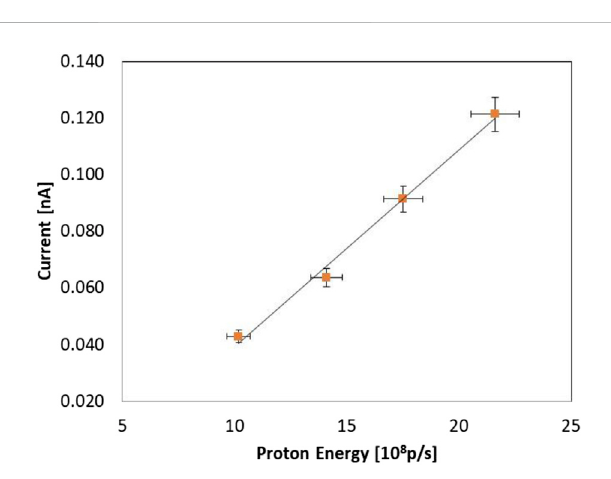
FIGURE 10 Average current measured by the 1 μ m-thick CsPbCl 3 IDE/Pd prototype, #7 (applied voltage V = 2 V) as a function of the proton fl ux impinging on the detector area, measred at different energies and extraction currents, respectively in the ranges 100 – 228 MeV and 1 – 10 nA. Best- fi t to data shows a linear